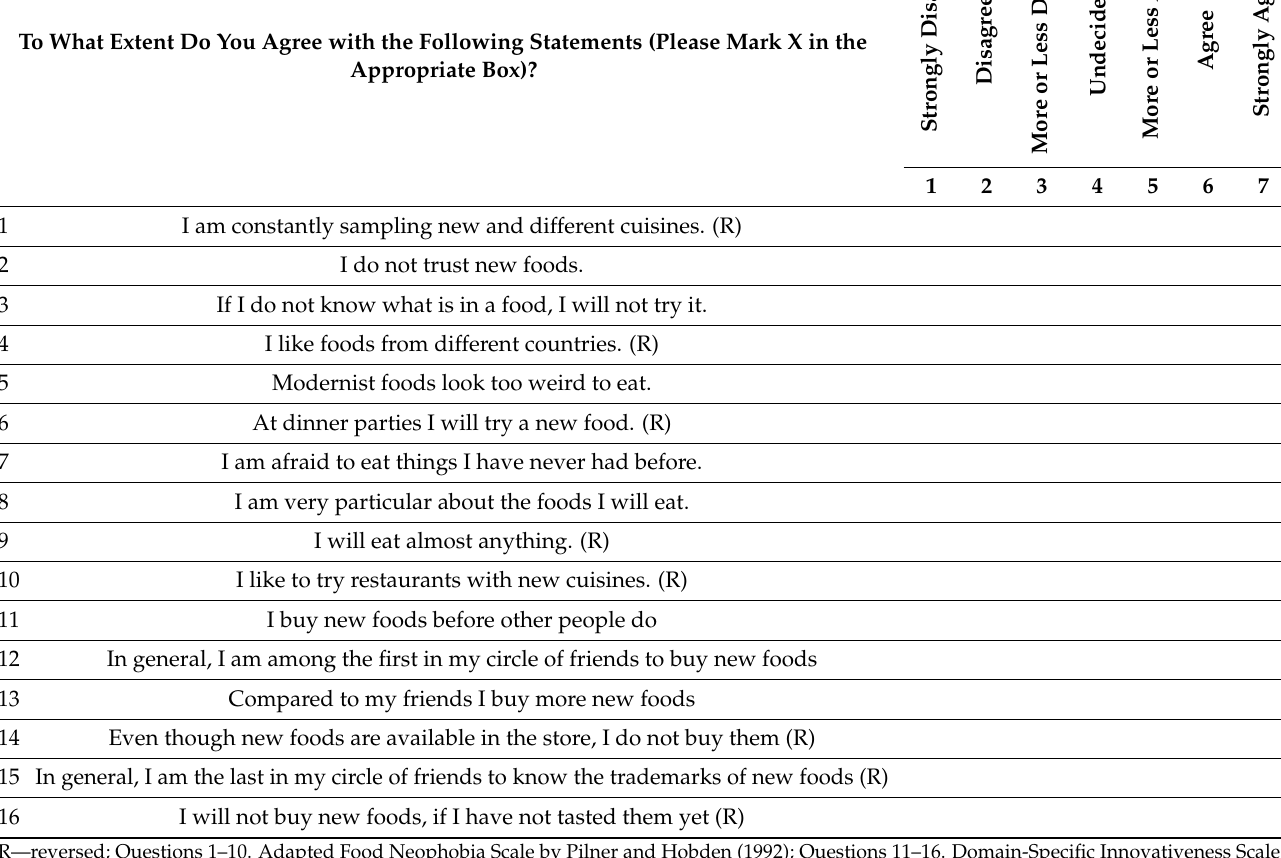
To What Extent Do You Agree with the Following Statements (Please Mark X in